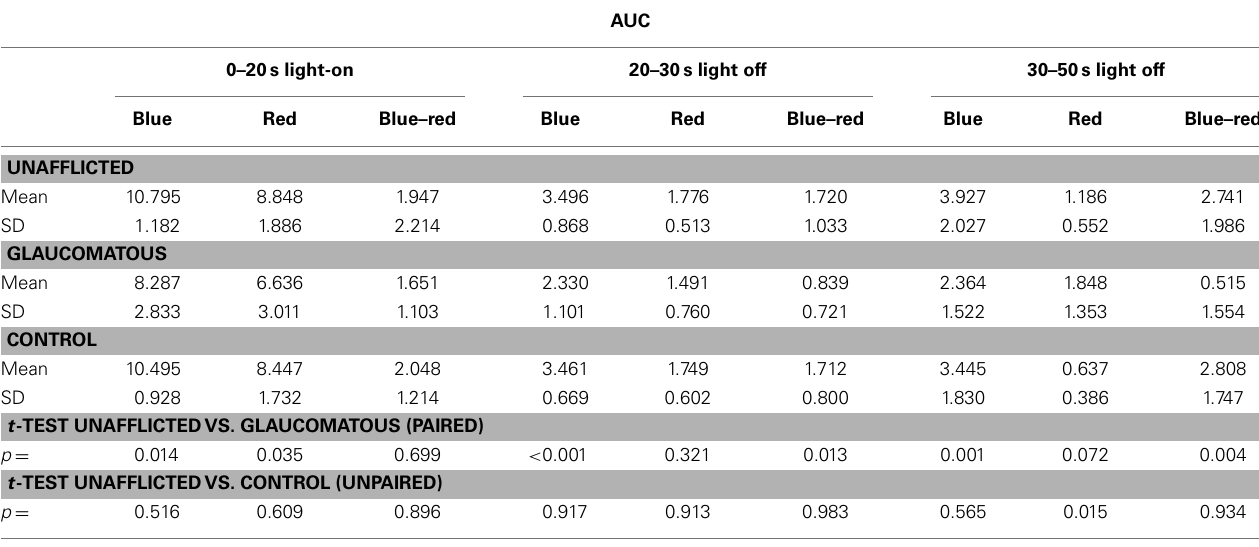
Table 2 |The pupillary responses during and after light stimulation in 11 patients (unafflicted and glaucomatous eye) and in 11 healthy, age-matched